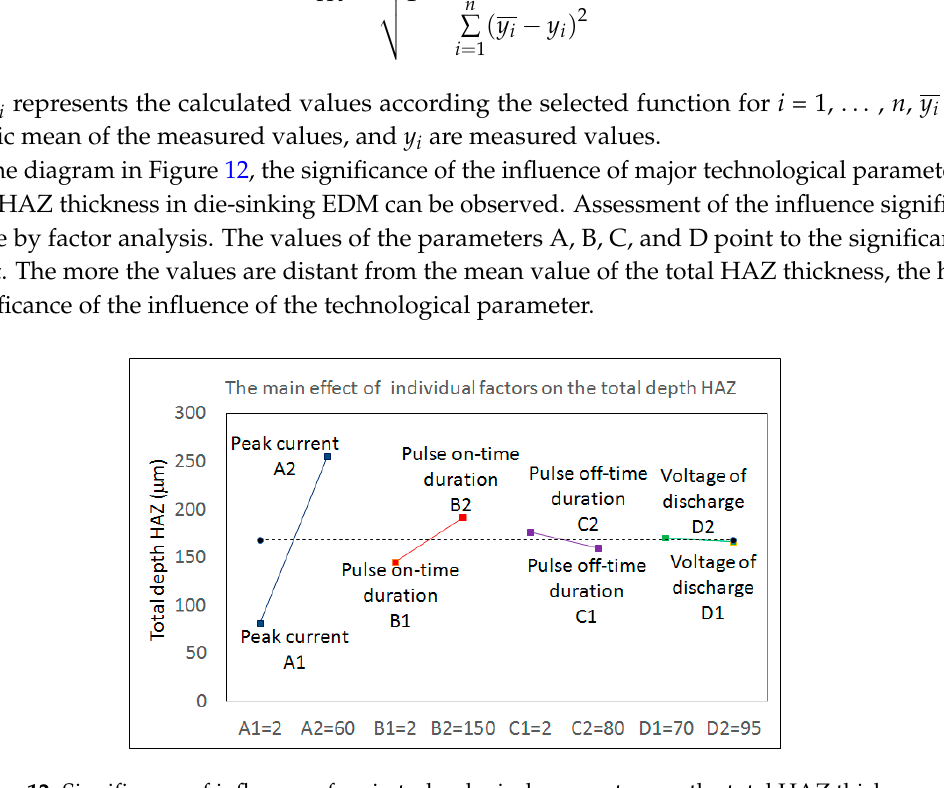
Figure 12. Significance of influence of main technological parameters on the total HAZ thickness at die-sinking EDM.